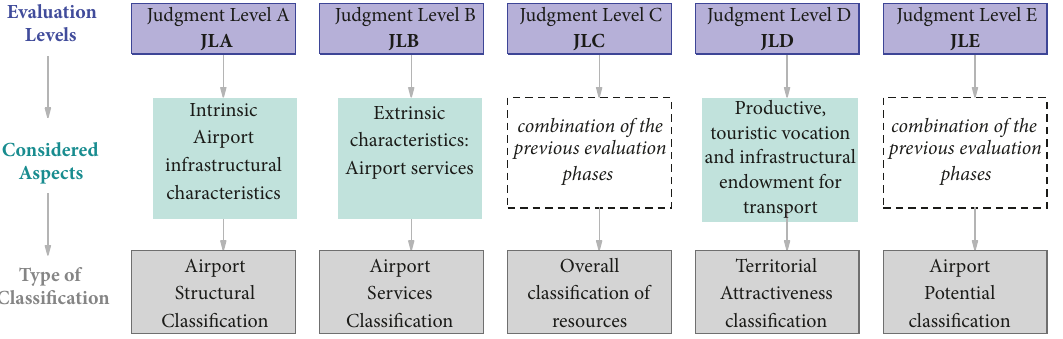
Figure 2: Judgment Levels